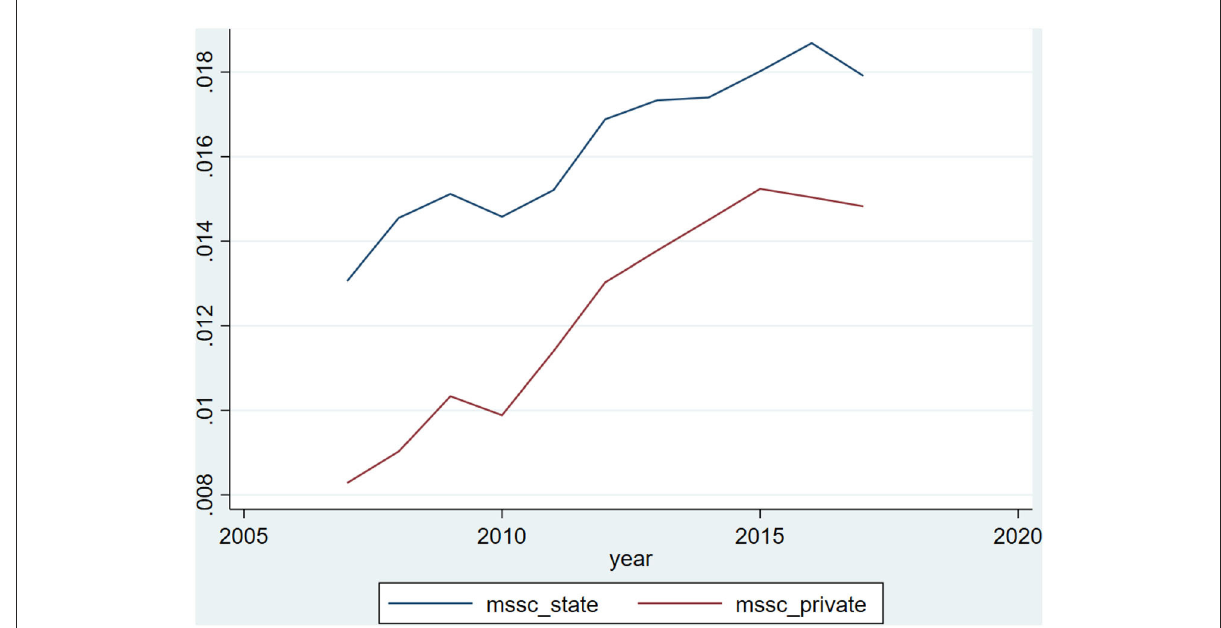
FIGURE2 Social insurance contributions burden SOE vs. NON-SOE. Mean annual social insurance contributions burden over the sample period separately for state-owned enterprises and non-state-owned enterprises. This graph plots the annual mean SSC over the sample period, 2008–2017. SSC is the ratio of social insurance contributions to revenue. In this graph, a firm is an SOE if its controlling shareholder belongs to the state, otherwise, it is a non-SOE. All observations are subject to the criteria described in Table 1. Source: The author’s calculations are based on data from the sources indicated in Section Sample and data